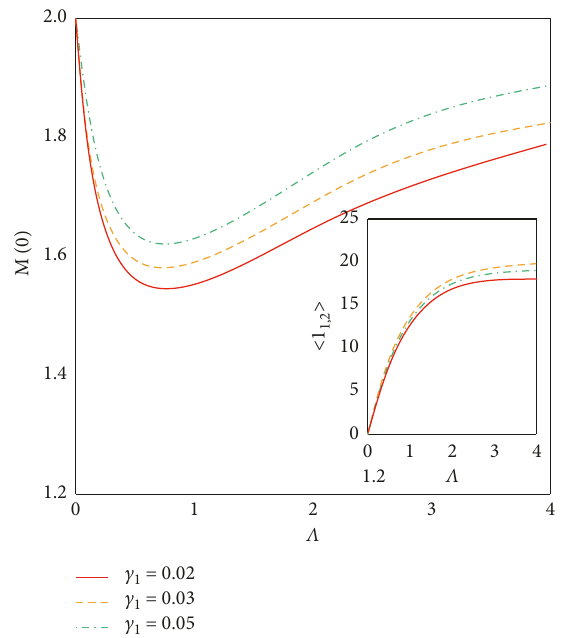
Figure 2: Variation curve of zero-frequency output spectrum M (0) with incoherent pumping rate Λ